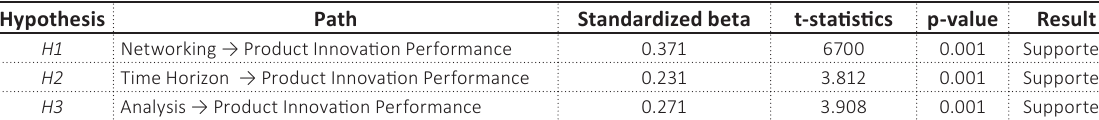
Figure 2. Visualization of path coefficients Table 3. Path coefficients